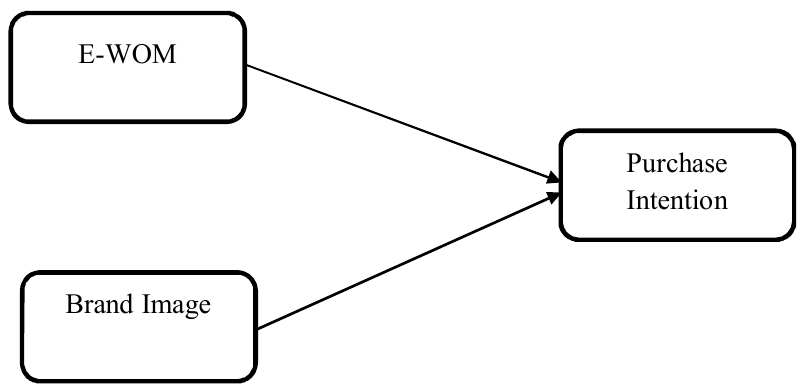
Fig. 1. The structure of the proposed